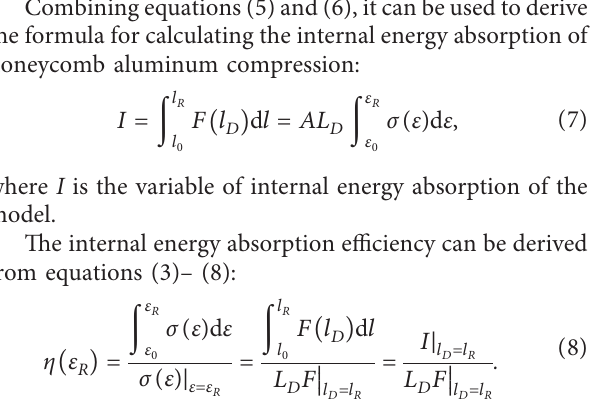
Figure 5: Stress-strain curve of honeycomb aluminum in out-of- plane quasi-static compressive load